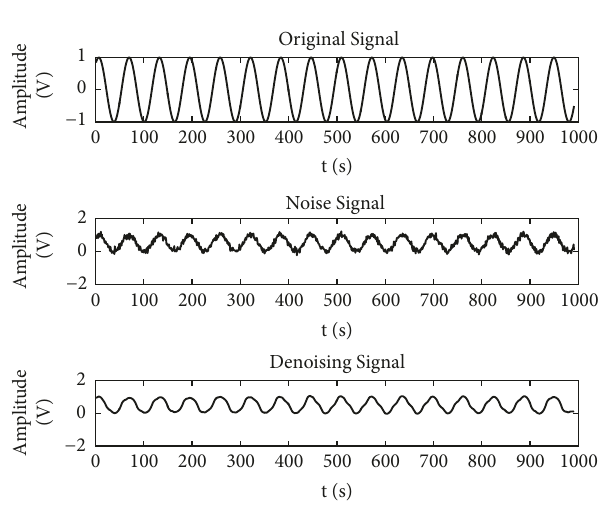
Figure 5: PCNN noise reduction results.